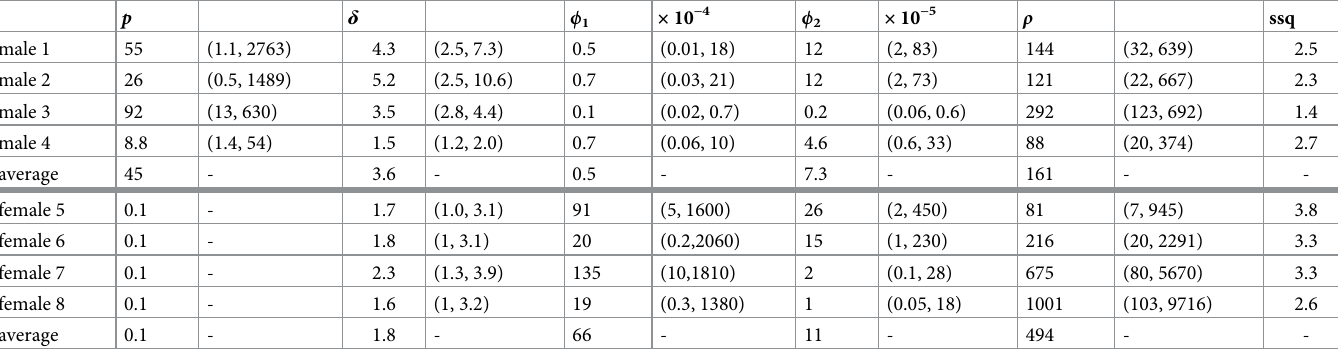
Table 1. Individual parameter estimates for male and female groups.